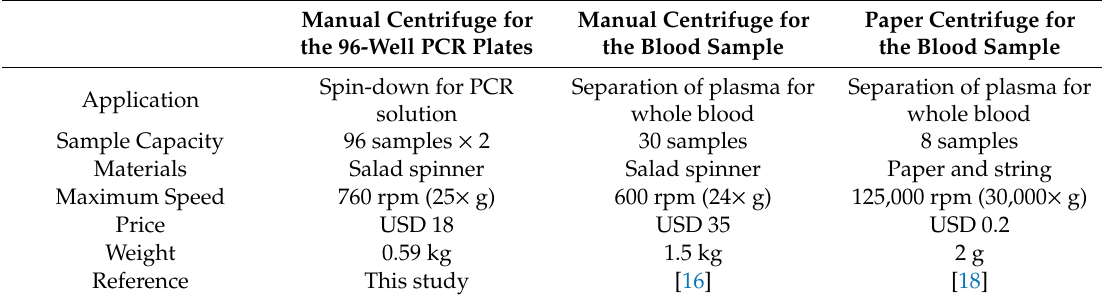
Table 1. Features of hand-powered manual centrifuges for various